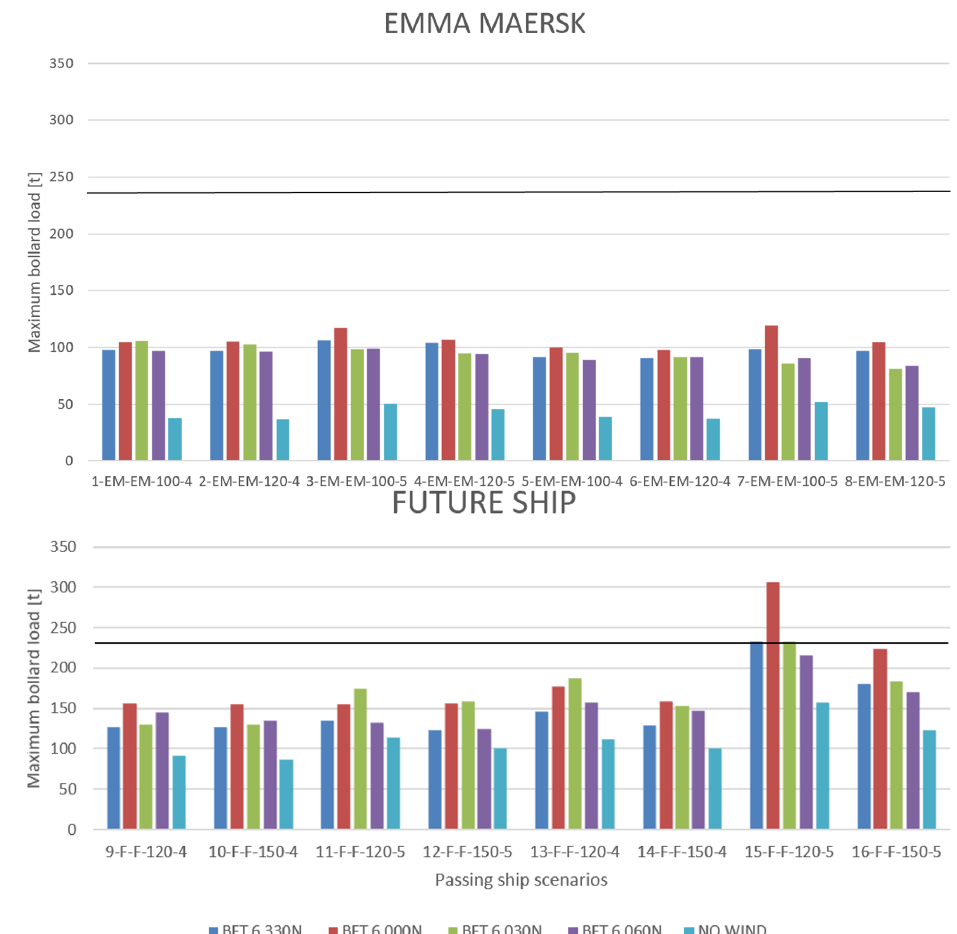
Figure 18. Maximum bollard loads results for the Emma Maersk and the future vessel subjected to passing-ship